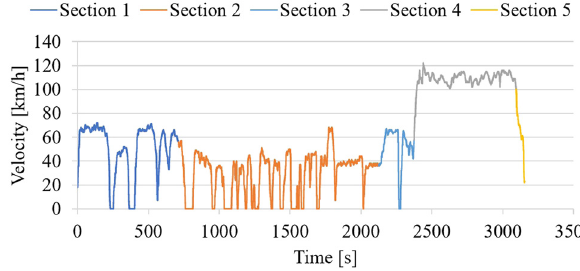
Figure 5: Velocity pro fi le on the Ch ȩ ciny – Kielce – Ch ȩ ciny route in the morning.